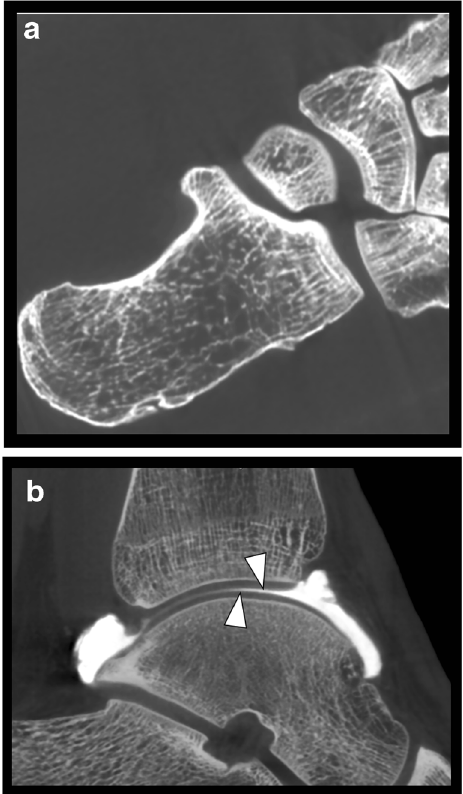
Fig. 2 Evaluation of bone architecture and normal articular cartilage. a . Axial CBCT image of a cadaver foot illustrating exquisite detail of the cortical and trabecular bone architecture. b . Sagittal reformatted image of a CBCT-A of the talocrural joint showing smooth surface of normal articular cartilage surface of distal tibia and talar dome